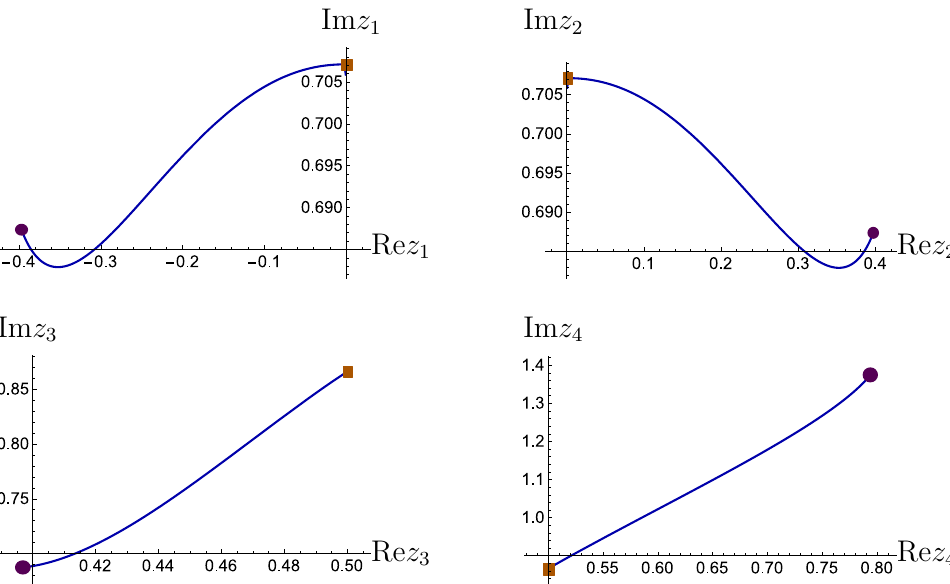
Figure 2 . Numerically integrated domain-wall with z 1 = (cid:22) z 2 that interpolates between AdS 4 (cid:0) solutions with SU(3) U(1) symmetry in the UV (brown square) and SO(4) symmetry in the IR (cid:2) (purple circle). This domain-wall is dual to the GY (cid:13)ow reviewed in section